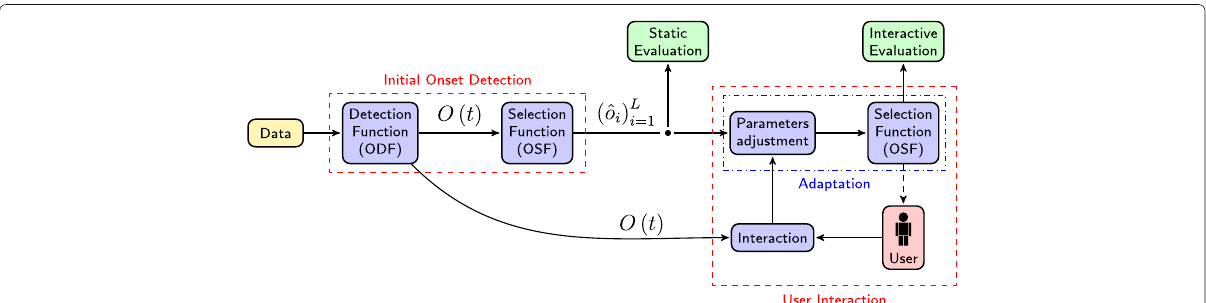
Fig. 4 Block diagram of the proposed scheme: an initial onset detection is performed on the input signal ( Data ) in the initialonsetdetection block; staticevaluation assesses the performance of the stand-alone algorithm; the userinteraction block introduces human verification, interaction and correction; interactiveevaluation assesses the performance of the interactive